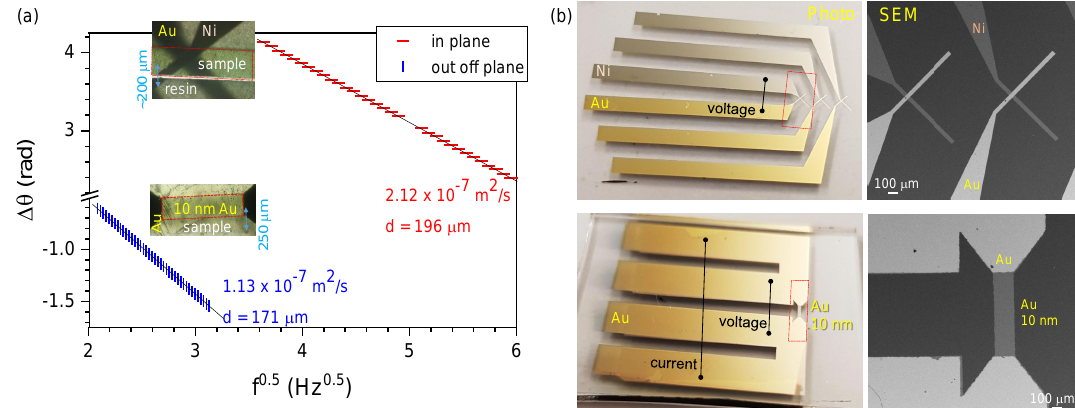
Figure 2. ( a ) Thermal wave Equation (1) measurements of the NC crystals (2 wt%) containing polymer across the sample (out-of-plane) and along the polymer film (in plane). Equation (1) is linearised by ∆Θ ∝ (cid:112) f presentation. The thickness of the sample d was different. Insets are optical transmission micrographs of the measurement region. It is important to place the thermocouple within the projection cross section of the sample. ( b ) Photos show the thermocouple and resistance contacts evaporated onto a glass substrate (see Figure 1 for designation of the current and voltage connection ports). SEM images of the sensor regions.